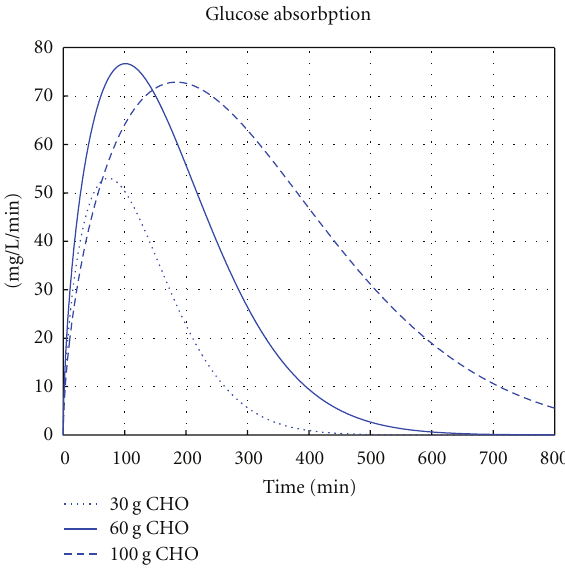
Figure 8: Absorption scenarios taken into account based on the use of the